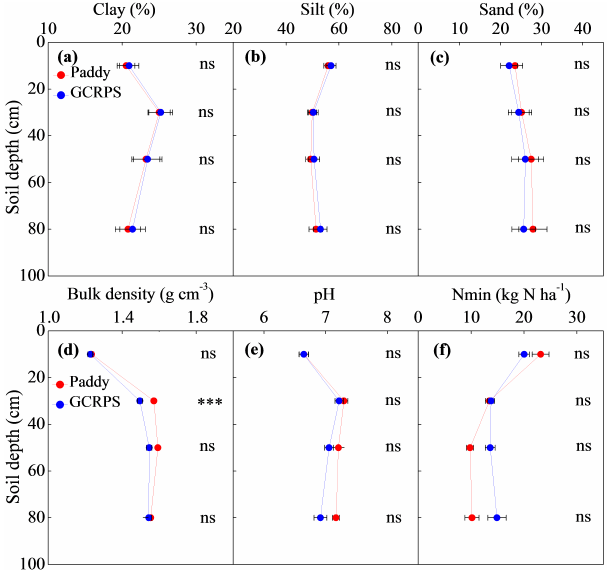
Figure 2. Average soil clay, silt, and sand contents (for 0–20 and 20–40cm, n is 49; for 40–60cm, n is 36; and for 70–90cm, n is 21), soil bulk density, pH, and mineral nitrogen concentrations (N min ; for 0–20 and 20–40cm, n is 147; for 40–60cm, n is 108; and for 70– 90cm, n is 63) at different soil depths from 49 paired sites cultivated either under traditional paddy fields or GCRPS. Errors bars indicate SEM (standard error of the mean) and ∗∗∗ denotes significance at a 0.001 probability level. Values that are not significant are denoted by ns .